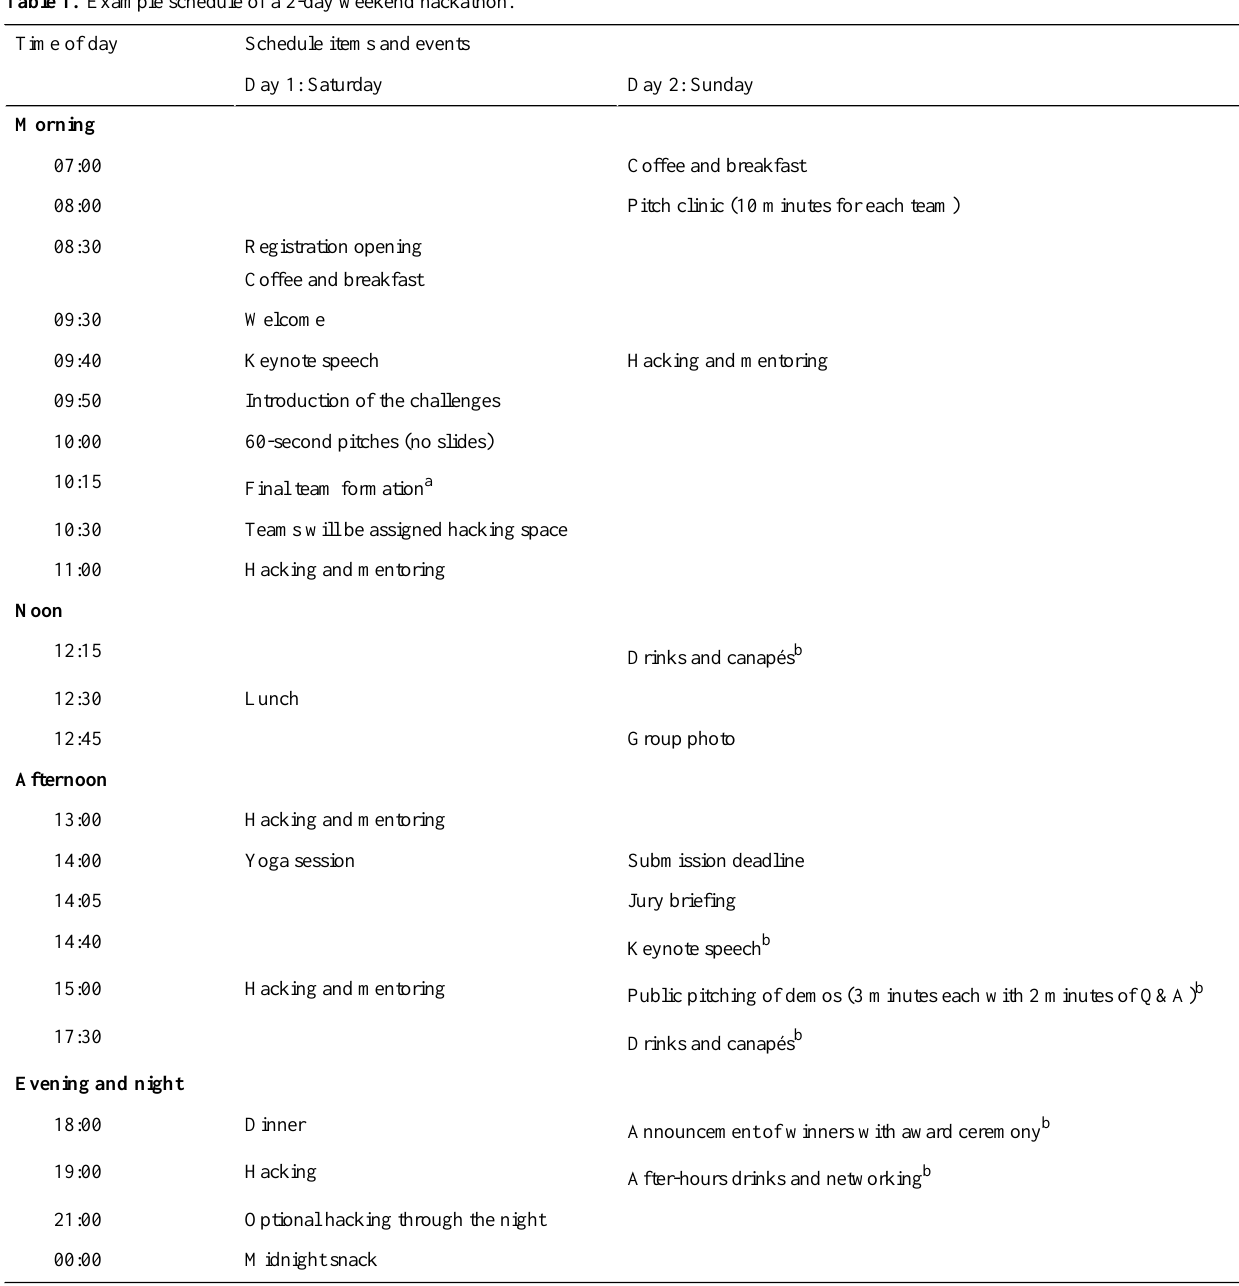
Table 1. Example schedule of a 2-day weekend hackathon.